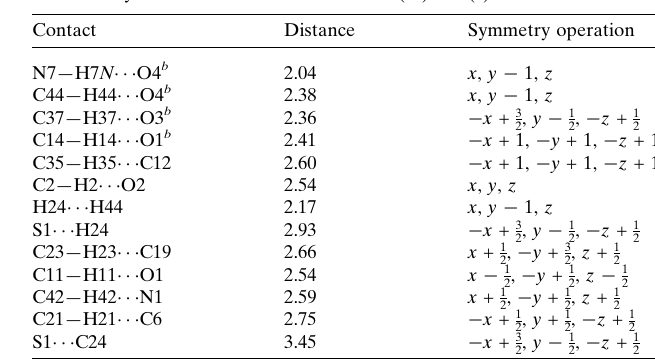
Table 3 A summary of short interatomic contacts (A˚ ) for (I) a